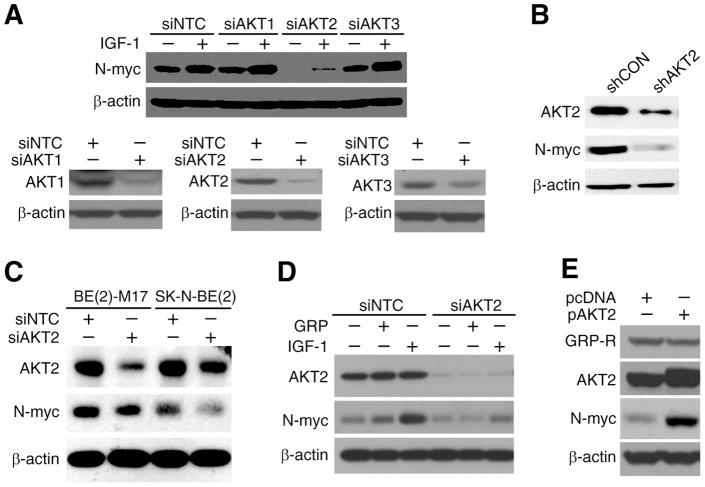
AKT2 regulated N-myc expression.(A) BE(2)-C cells were transfected with siRNA pools specifically targeting siAKT1, siAKT2, and siAKT3. Cells were serum-starved for overnight 48 h after transfections, and then stimulated with IGF-1 (100 nM) for 2 h. N-myc expression was examined by Western blotting. Notably, only siAKT2 decreased N-myc expression. Knockdown efficiency of each isoform was confirmed at 48 h post-transfection. (B) N-myc expression was examined in stably-transfected BE(2)-C/shCON and BE(2)-C/shAKT2 cells using Western blotting. N-myc expression was reduced in AKT2 stably knockdown cells. (C) BE(2)-M17 and SK-N-BE(2) cells were transiently transfected with AKT2 siRNA (siAKT2) pool. Proteins were extracted from cells 72 h after transfected with siAKT2. N-myc expression was downregulated in siAKT2 cells as examined by Western blot analysis. (D) BE(2)-C cells were transiently transfected with siAKT2 for 24 h, then serum-starved for another 24 h. They were then treated with either GRP (100 nM) or IGF-1 (100 nM) for 2 h. Western blotting showed suppression of N-myc by siAKT2 despite stimulation with GRP or IGF-1. (E) BE(2)-C cells were transiently transfected with the AKT2 overexpression plasmid pcDNA-Myr-AKT2 (pAKT2) or a control plasmid pcDNA for 48 h. AKT2 overexpression was confirmed by Western blot analysis. N-myc expression increased, but GRP-R was not changed in AKT2 overexpressed cells.